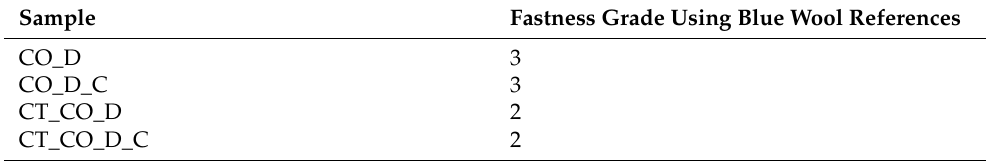
Table 6. Colour fastness to light.